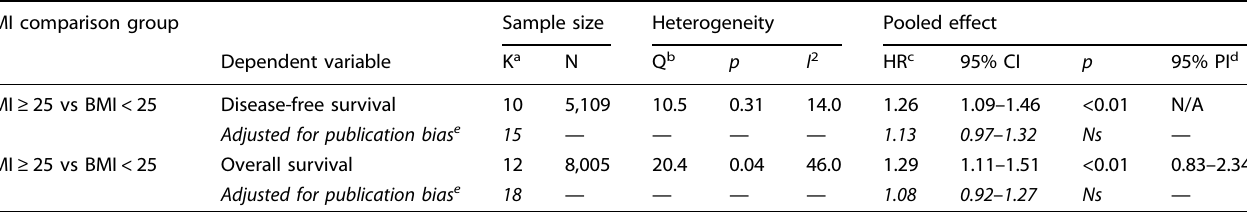
Table 2. Pooled effects of overweight on disease-free survival and overall